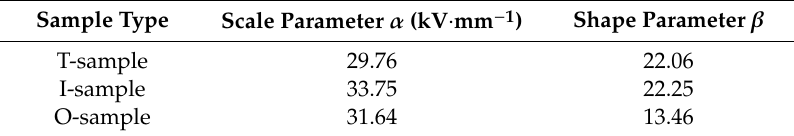
Figure 8. Weibull distribution curves of breakdown field strength of samples. Table 3. Weibull distribution parameters of breakdown field strength of samples.